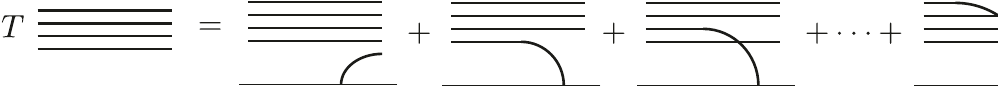
Figure 7 : Acting with T